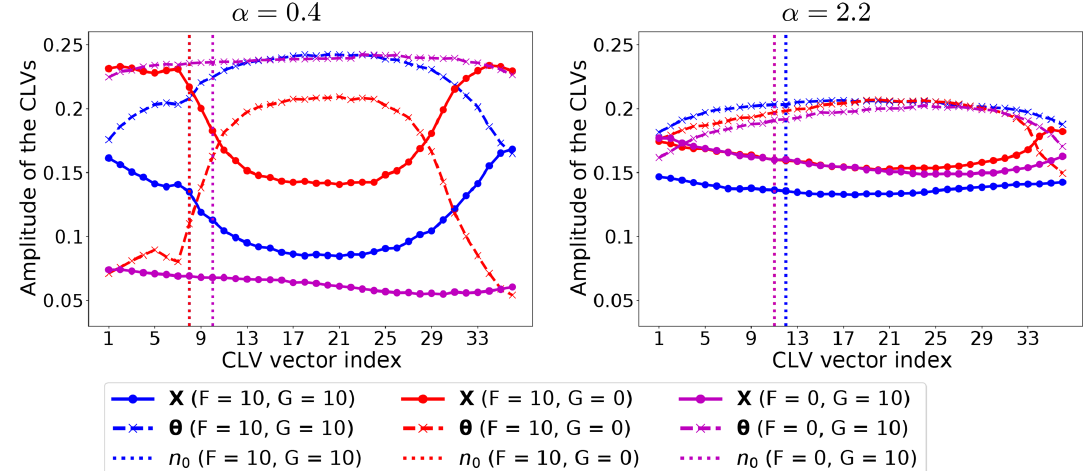
Figure 4. Normalized time-averaged amplitude of CLV components (the absolute value) for α = 0 . 4 and α = 2 . 2. In both cases γ = 1. The vertical lines indicate the corresponding dimension of the unstable–neutral subspace, n 0